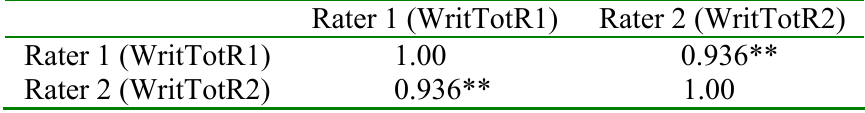
Correlation Matrix for the Writing Test, Pearson Product-Moment ( N